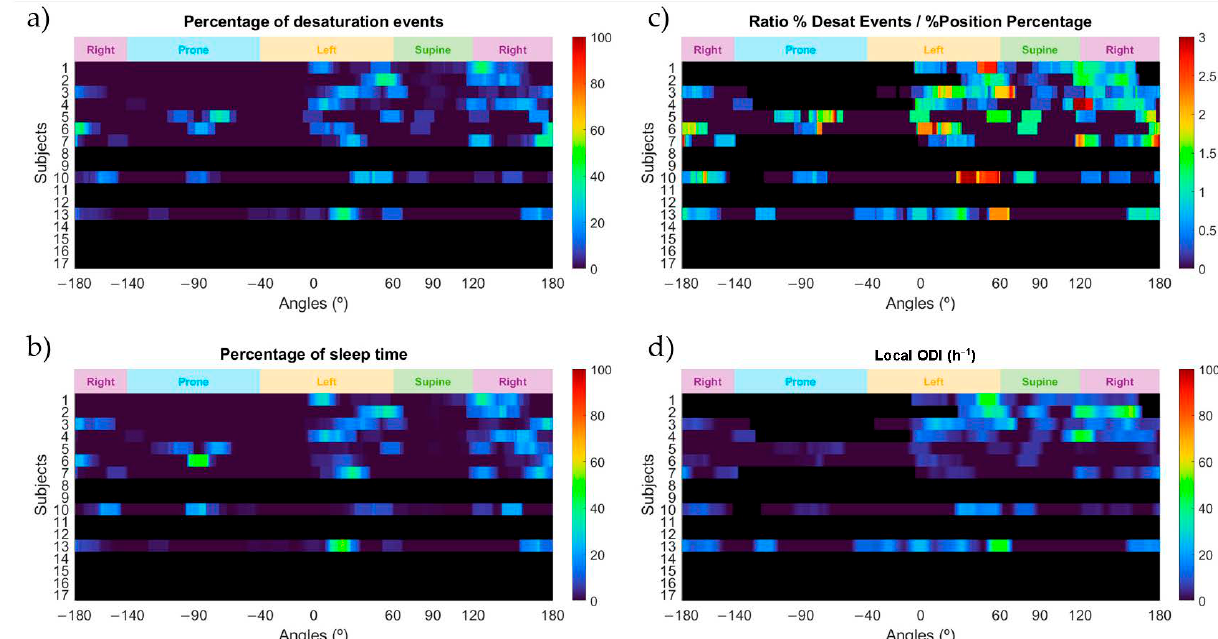
Figure 6. Heatmaps of the percentage of desaturation events ( a ); the percentage of sleep position time ( b ); the ratio between the percentage of desaturation events and the percentage of sleep position time ( c ); and the local ODI ( d ) for each sleep position angle and for the subjects who underwent positional treatment. Black colors shown in the heatmap indicate that either the subject was not treated with the ‘SleepPos’ app positional treatment or the ratio and the local ODI could not be calculated for that specific angle due to no time slept on it.